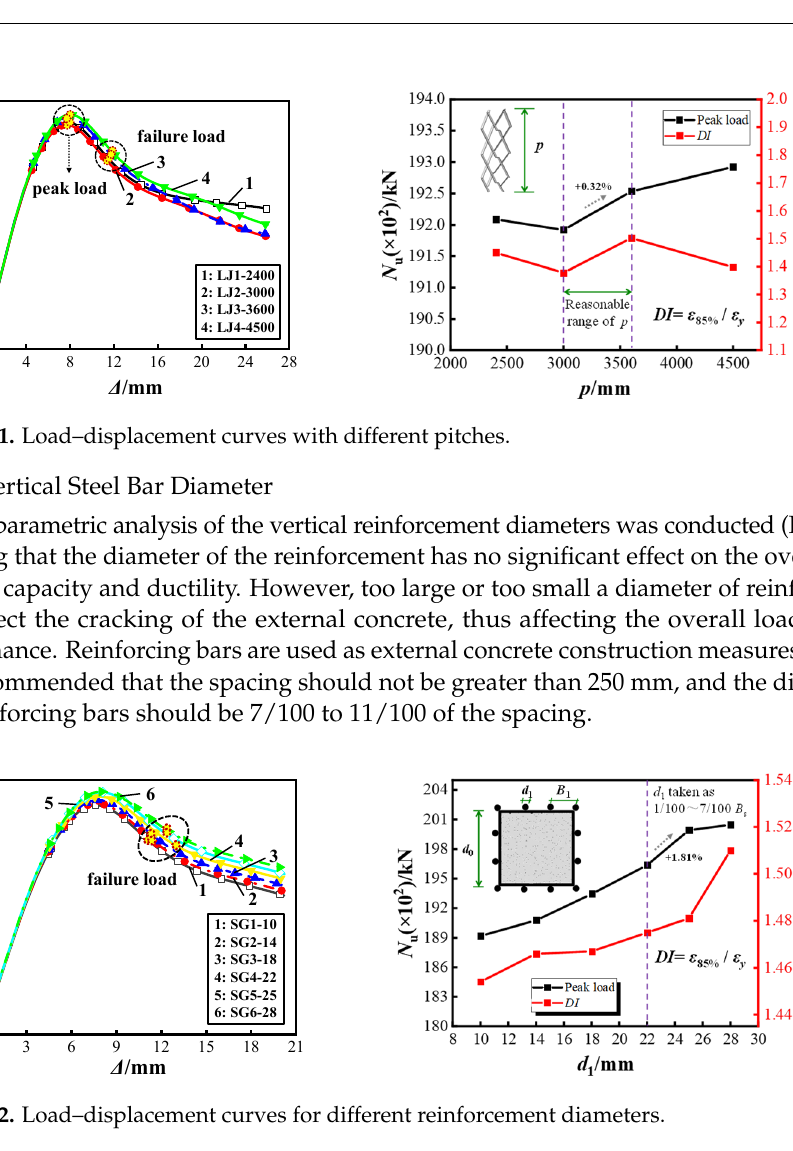
Figure 23. Load–displacement curves with different eccentricities.